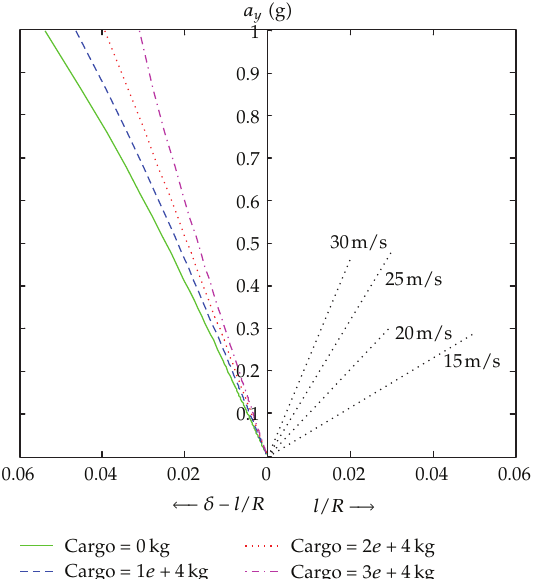
Figure 6: V -handling diagram for tractor semitrailer with two rear